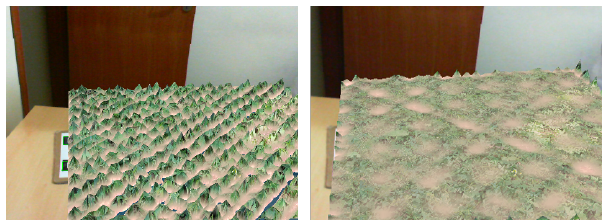
Fig. 3. The erosion post processing, on the left a noisy terrain generated and to the right the eroded terrain.